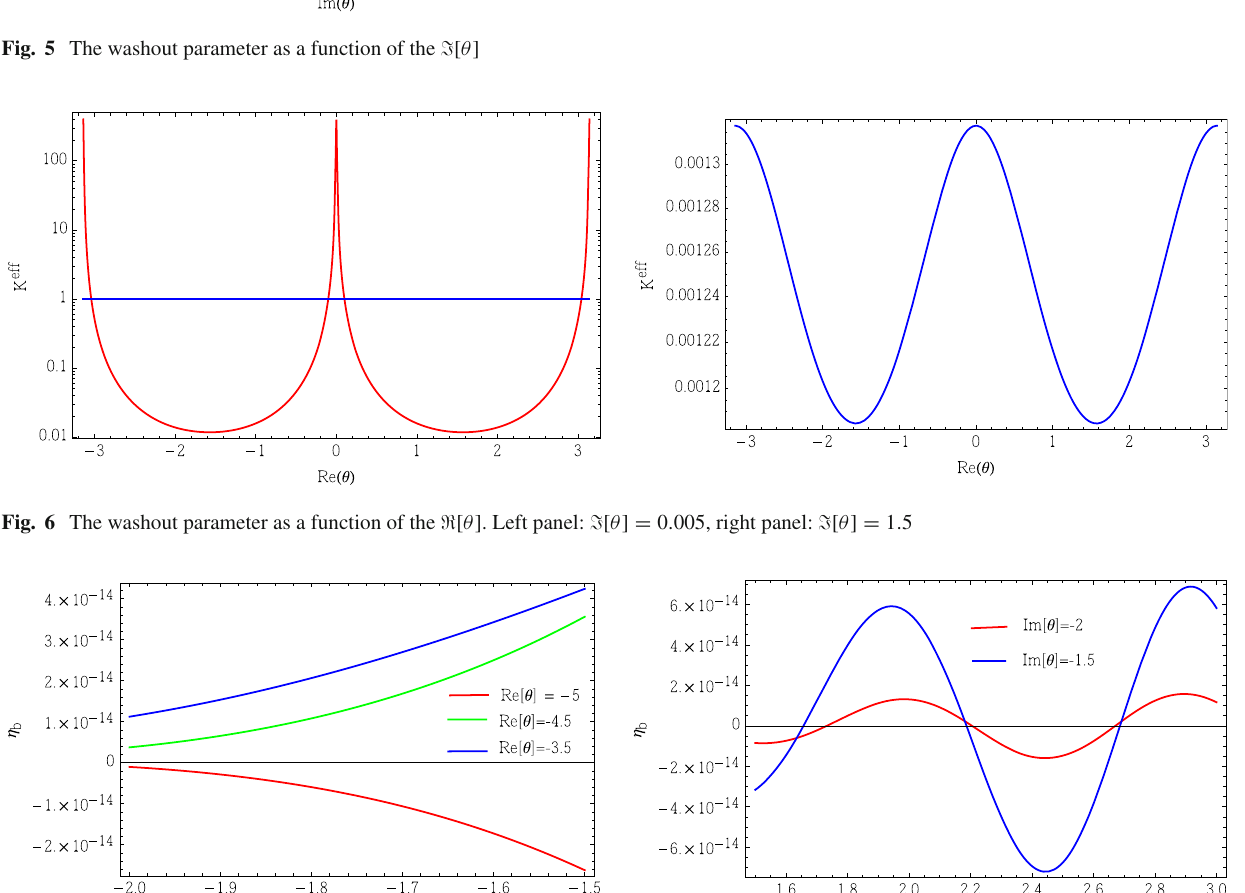
fixed as Y ( N ) = Diag ( 0.5 , 0.9i , 1.8 ) . Two VEVs are